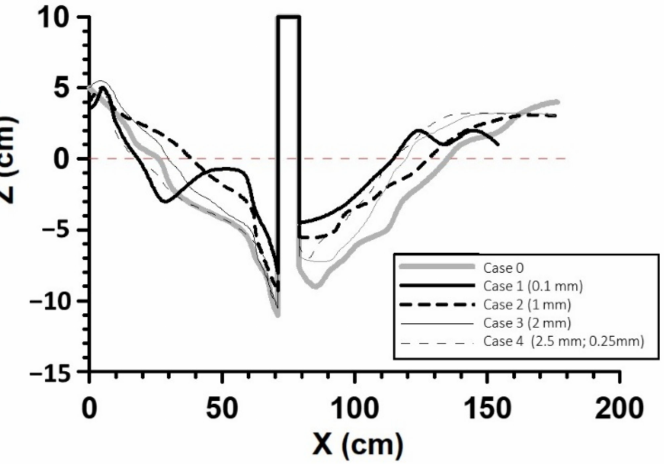
Figure 11. Change in centerline due to strip size (Z = 0 means initial bed, positive value means deposition and negative value means